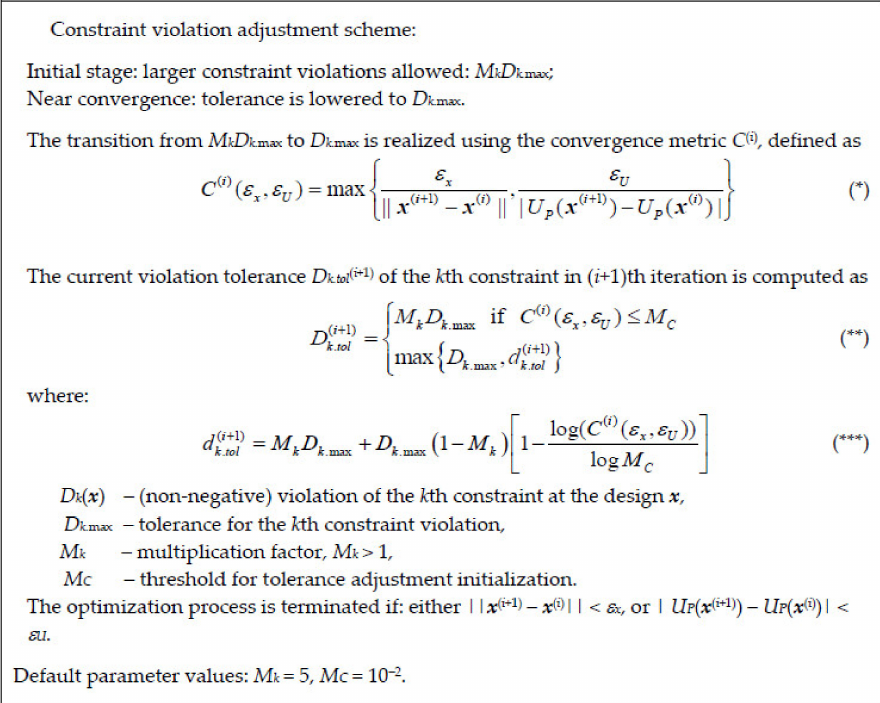
Figure 1. Adaptive constraint violation adjustment according to the methodology of [42].